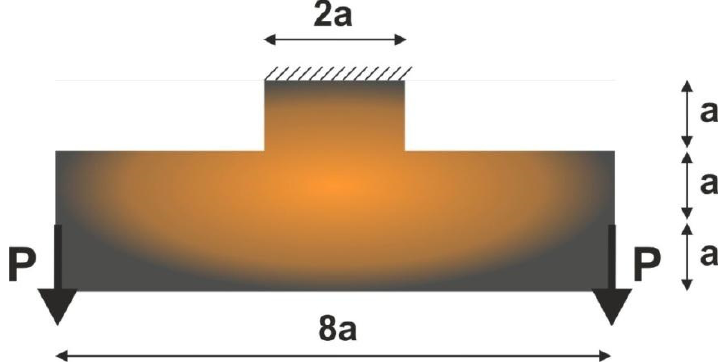
Figure 9. The test structure 1 with applied loads and support.